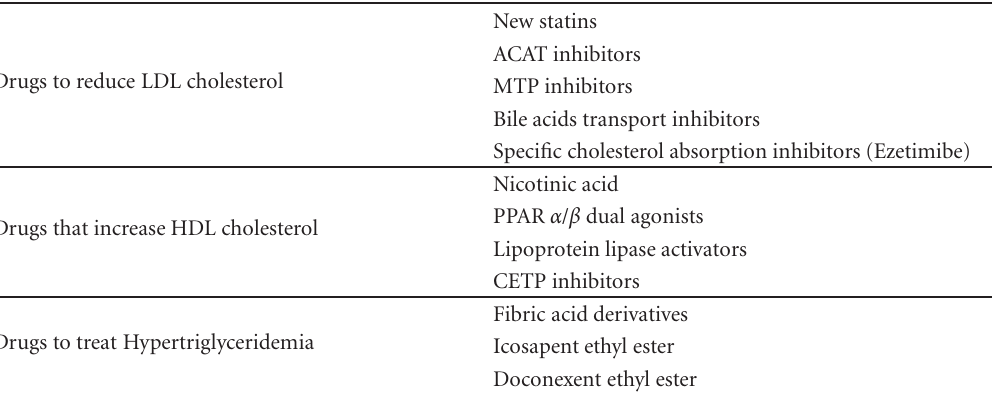
Table 2: Drugs recommended to normalise lipid disorders.